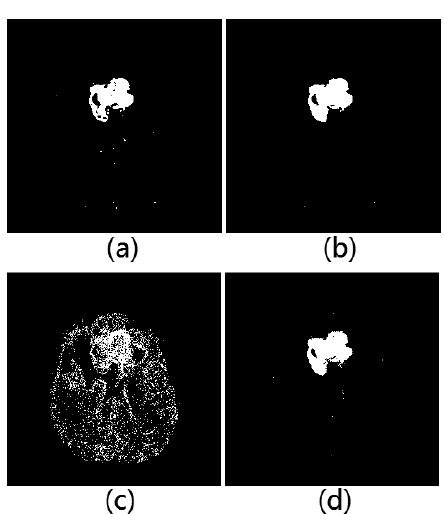
Fig. 7. With respect to image data of Fig 3, tumor segmen- tation on (a) no additive noise with FCM, (b) no additive noise with dwFCM, (c) added noise of SNR =10 with FCM, (d) added noise of SNR =10 with